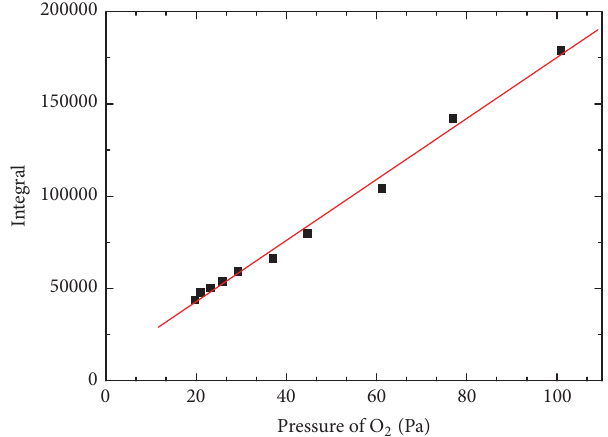
Figure 2: Calibration of EPR spectrometer using the line C of molecular oxygen. Linear dependency of absorption line integral 𝐼 C (i.e., double integral of measured signal) on oxygen pressure validates the calibration process and its slope provides a constant [ O ]/𝐼 2 C needed for the